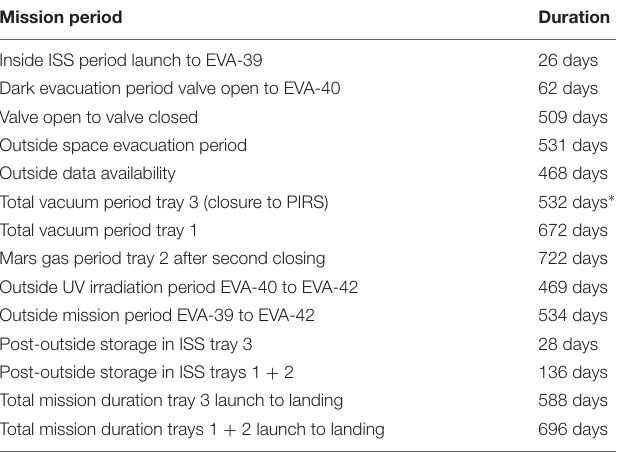
during the mission was 57.98 ◦ C at tray 3 compartment 4.